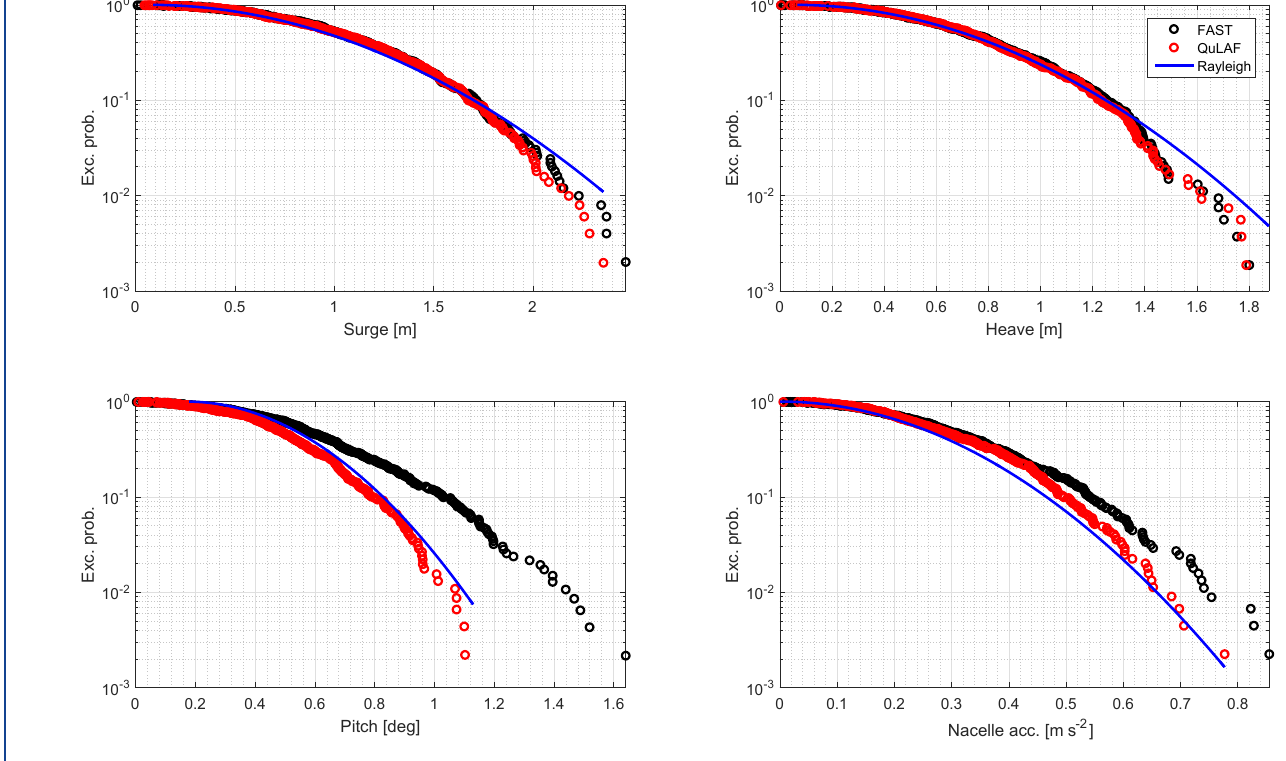
Figure 8. Exceedance probability of the response to irregular waves. Table 4. Summary of environmental conditions (Krieger et al., 2015) and DEL results obtained in FAST and